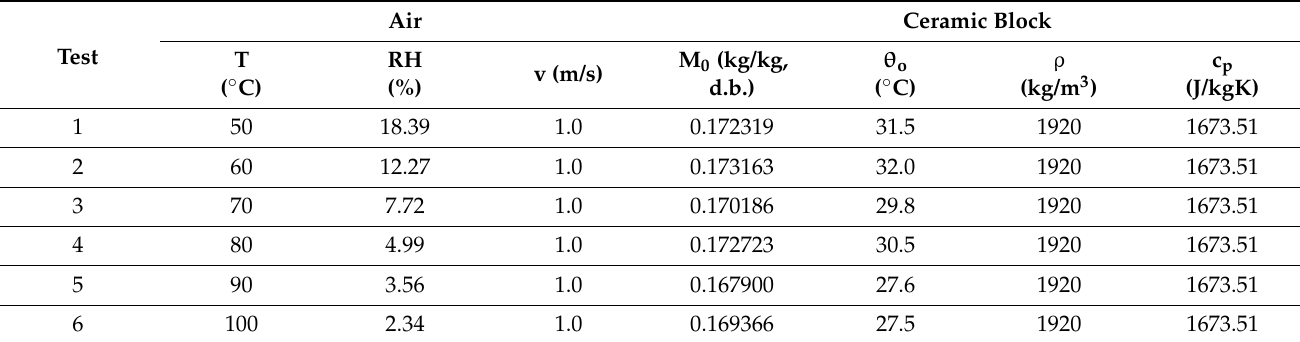
Table 3. Experimental parameters for the air and the ceramic block at the beginning of the drying process [14,20].